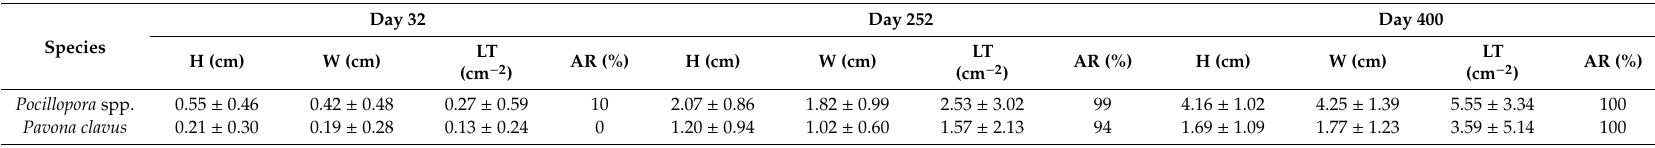
Table 1. Growth parameters ( ± SD). Height (H), width (W), live tissue (LT), and attachment rates (AR) for Pocillopora spp. and Pavona clavus , along three time points.